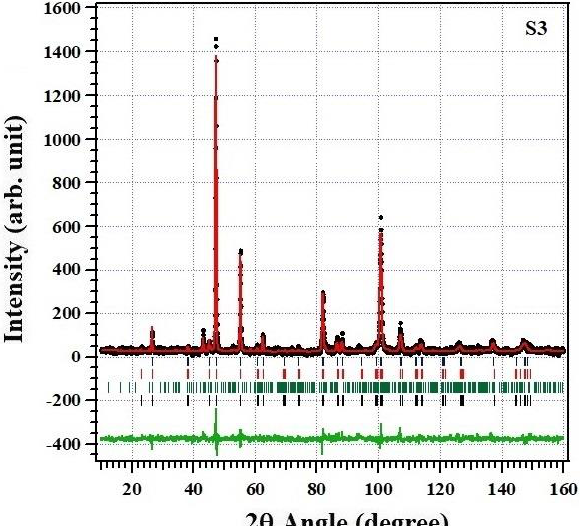
Figure 11. Neutron diffraction patterns of S3, Rietveld analysis results based on the nuclear- and magnetic phase using basis functions of IRreps(3), with  2 = 1.7.